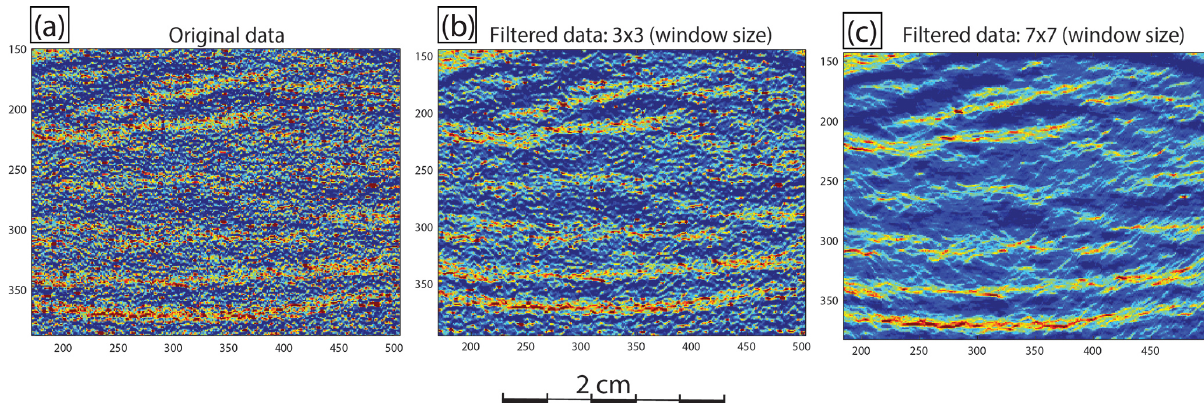
Figure 5. Application of the median filter to remove noises. (a) Original data; (b) filtered data with a 3 × 3 window size; (c) filtered data with a 7 × 7 window size.